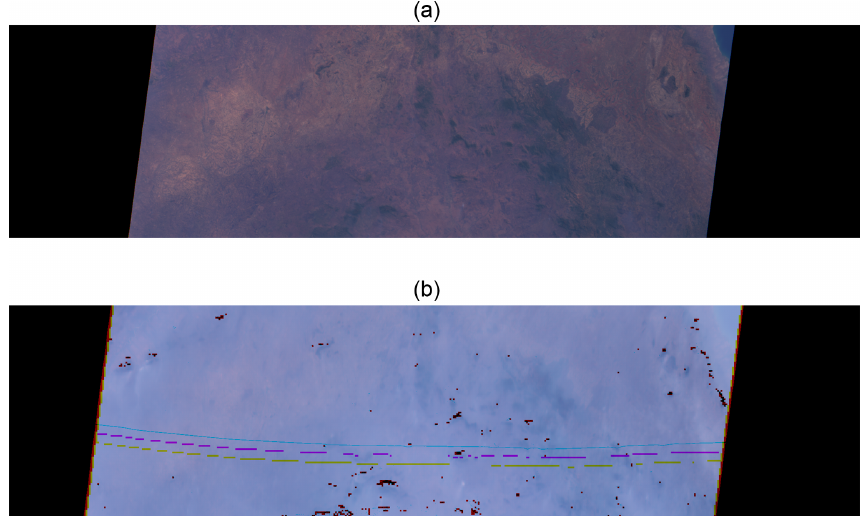
Figure 17. RGB maps of the original MISR L1B2 radiance product at the top of the atmosphere for Path 169, Orbit 78171, Block 102, and camera AN (a) and camera DA (b) . Linear dimensions are as described in the caption of Fig. 3. These maps show that the area was essentially clear throughout, possibly with a humid atmosphere or a thin cirrus veil. No rectangular clouds can be identified anywhere.